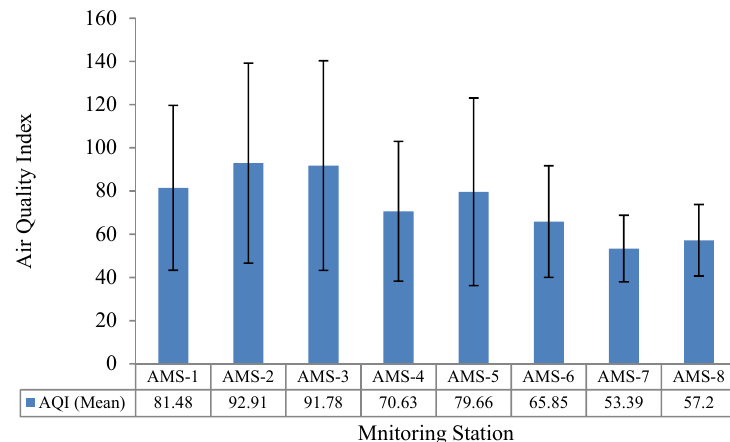
Fig. 4: Mean with standard deviation of AQI (Station Wise)